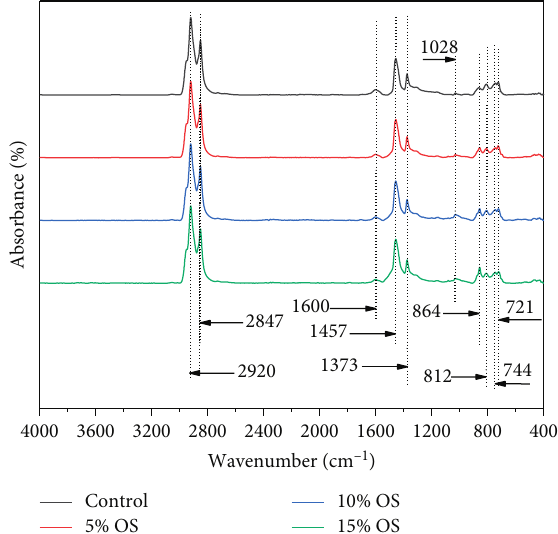
Figure 4: Fourier transform infrared spectrum of the studied